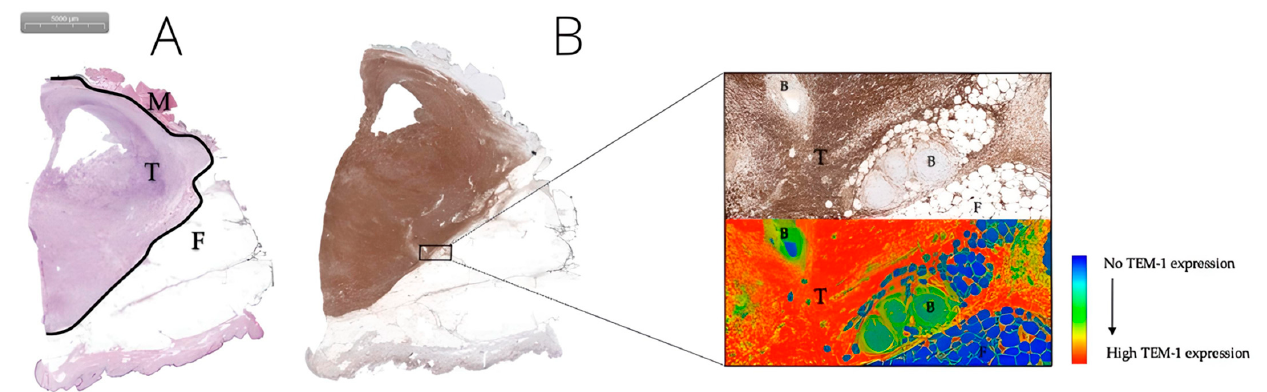
Figure 3. A grade 3 MFS tumor located in the upper arm of a 64-year-old female. H&E staining of MFS tumor tissue (T), the tumor border (black line), and adjacent muscle and fat tissue (M and F) ( A ). Corresponding TEM-1 staining ( B ): the upper right 30× enlarged image displays tumor tissue (T), blood vessels (B), and adjacent fat tissue (F). The lower-right corresponding image shows a gradient map of the same TEM-1 staining, which clearly delineates tumor from adjacent healthy tissue.